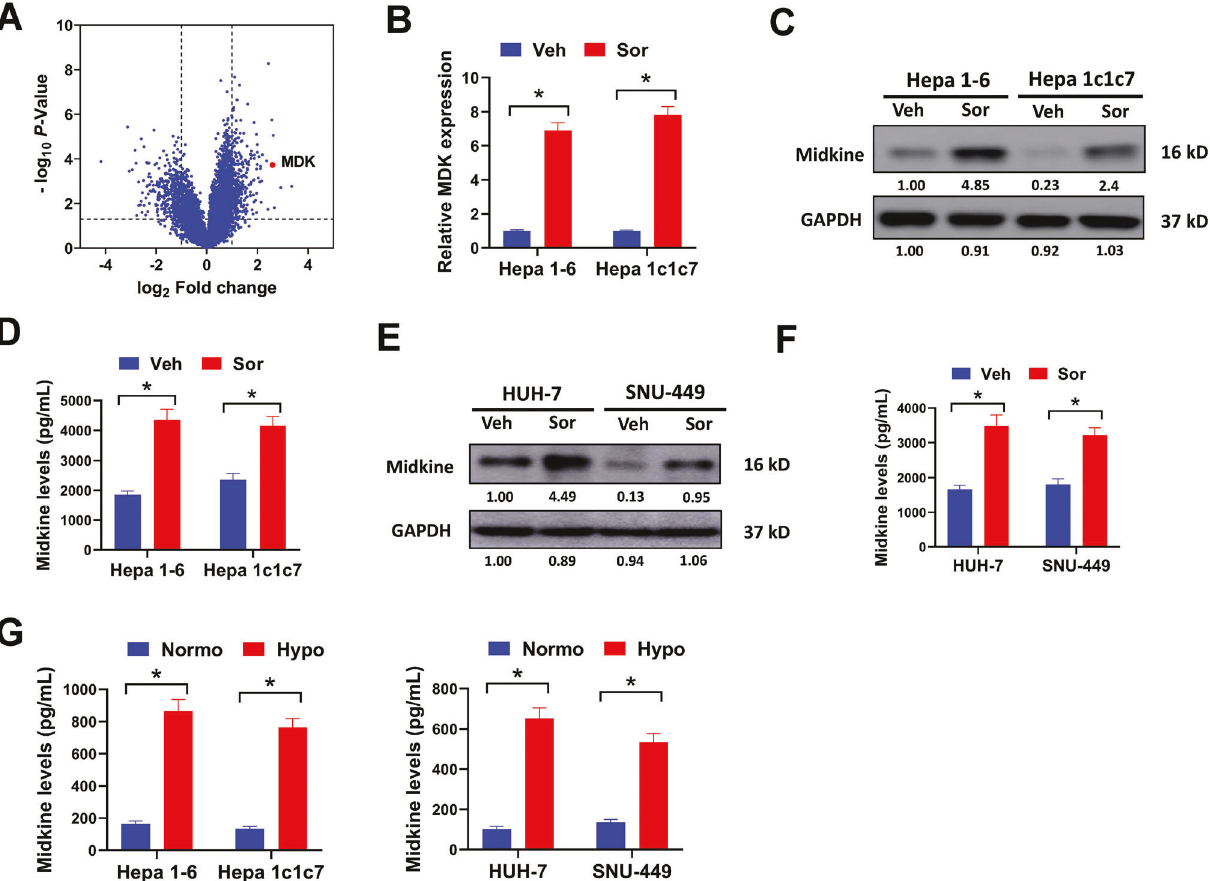
Fig. 2 Sorafenib treatment promotes midkine expression and secretion by HCC cells. A differentially expressed genes in orthotopic Hepa 1-6 tumors treated with sorafenib (Sor) or vehicle control (Veh) were depicted in volcano map. B , C midkine expression in orthotopic Hepa 1-6 and Hepa 1c1c7 tumors treated with sorafenib or vehicle control was evaluated by qRT-PCR ( B ) and western blot ( C ). D secreted mikdine in serum samples of orthotopic Hepa 1-6 and Hepa 1c1c7 tumors treated with sorafenib or vehicle control was measured by ELISA assay. E , F midkine expression in orthotopic HUH-7 and SNU-449 tumors treated with sorafenib or vehicle control was evaluated by qRT-PCR ( E ) and western blot ( F ). G secreted mikdine in serum samples of orthotopic HUH-7 and SNU-449 tumors treated with sorafenib or vehicle control was measured by ELISA assay. All assays were done with at least three repeats. Data were shown as mean ± s.d., * P <